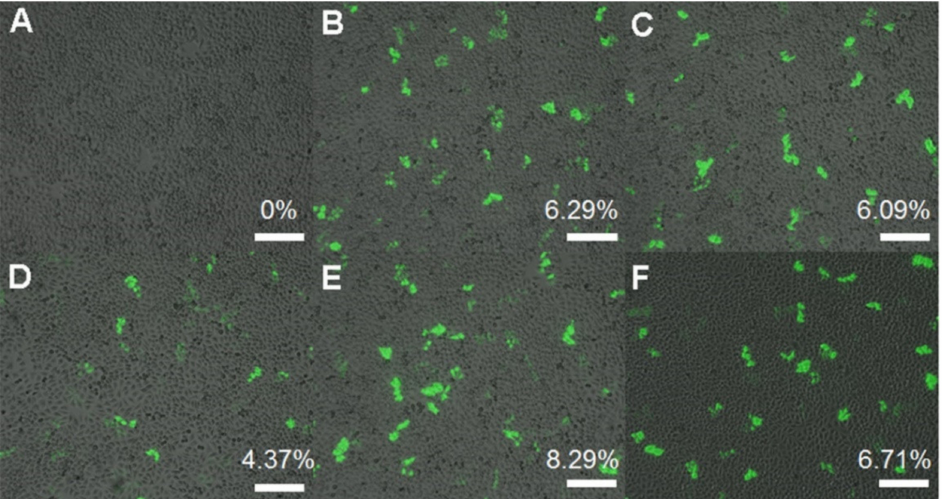
Figure 7. GFP transfection observation by fluorescence microscopy in HeLa cells. ( A ) cell only, ( B , E ) SP2K7 polyplexes, ( C , F ) SP2K10 polyplexes, and ( D ) PEI25K polyplexes. Transfection experiments were performed at weight ratios of ( B , C ) 10 and ( E , F ) 20. GFP expression (%) was calculated by the Image J